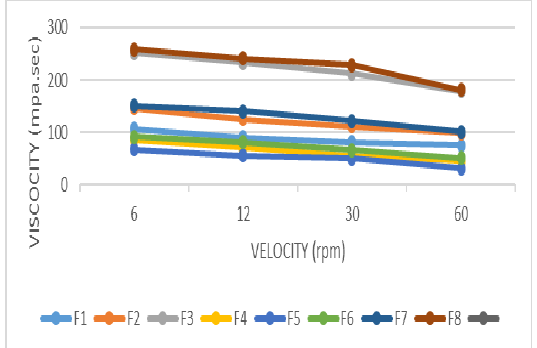
Figure 5. Viscosities data of prepared felodipine nanoemulsion formulas (F1, F2,F3,F4,F5,F6,F7,F8).